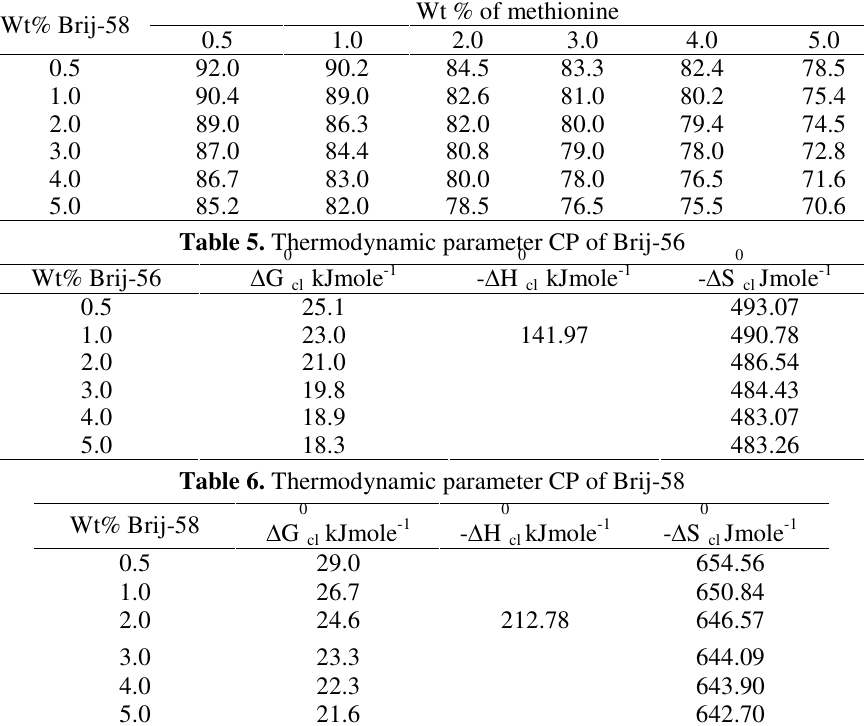
Table 4. Influence of methionine on CP of Brij-58